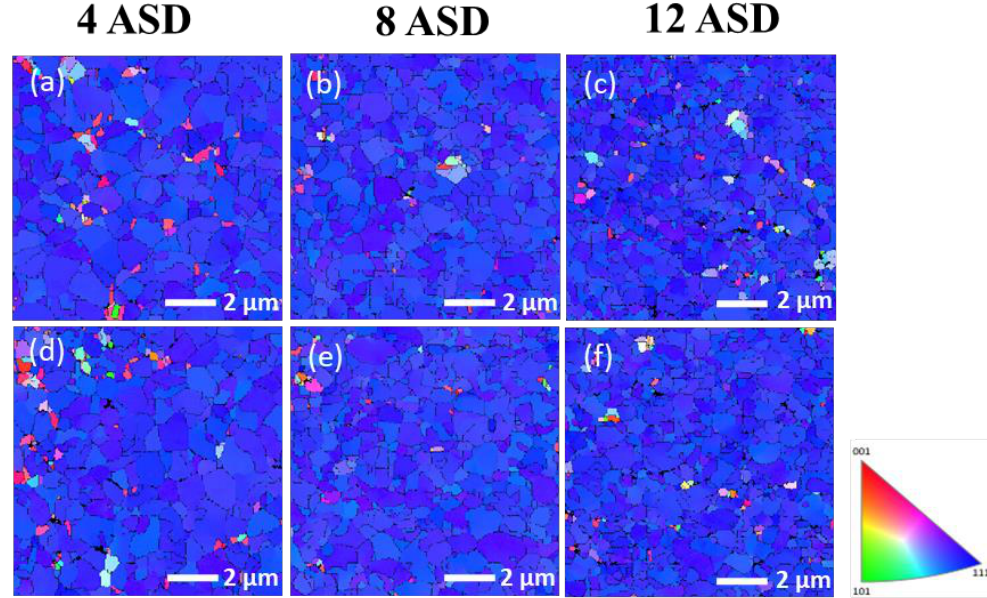
Figure 5. Top-view EBSD images of the as-fabricated ( a – c ) and annealed ( d – f ) nt-Cu films deposited at 35 ◦ C with various current densities of 4, 8, and 12 ASD, respectively. The annealing was conducted at 200 ◦ C for 10 h. Table 3. Degree of (111) orientation and grain size of the films deposited at 35 ◦ C. Samples (As-Fabricated)